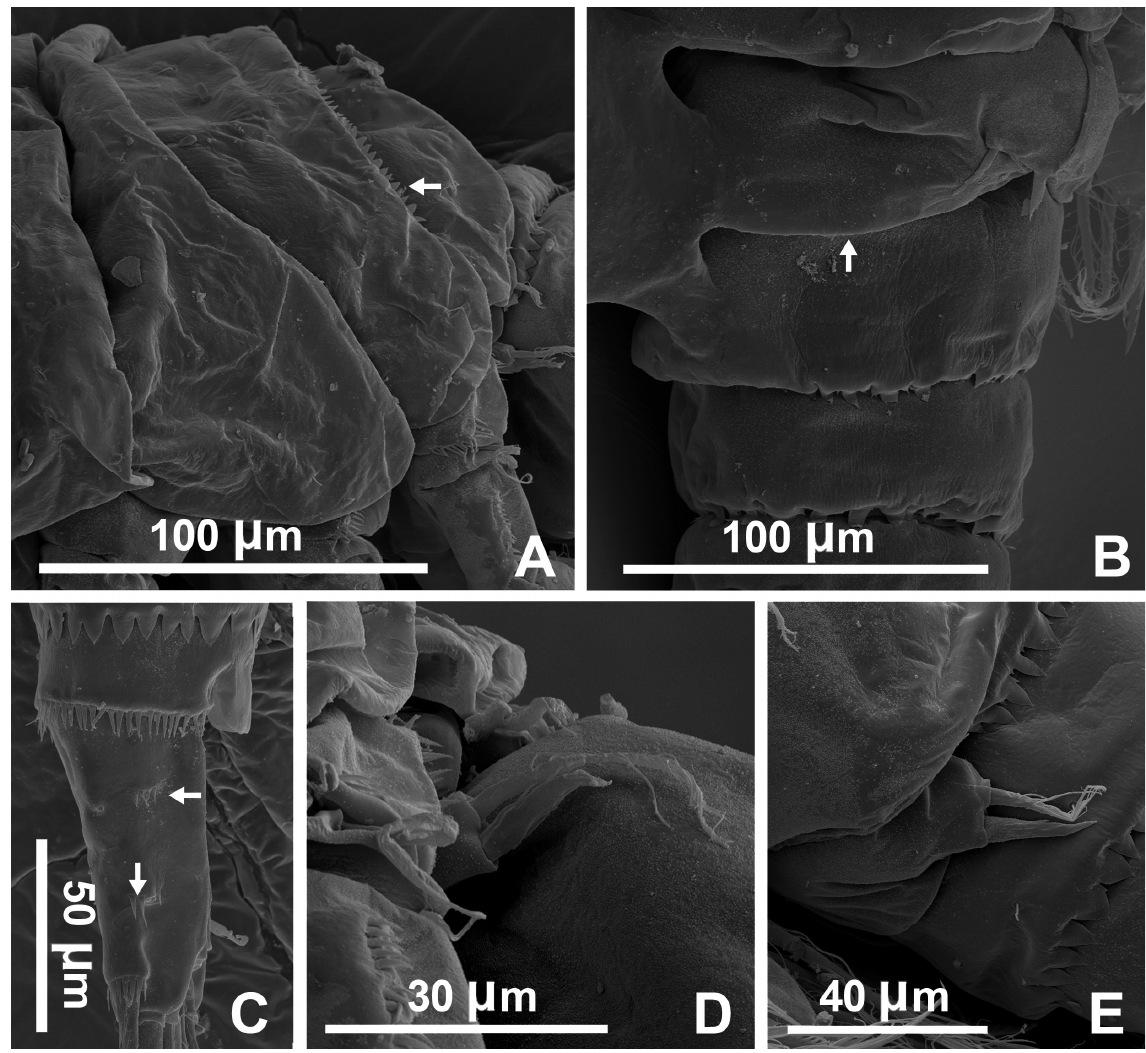
Fig. 11. Metacyclops brancelji sp. nov., SEM photographs of additional material (Rakhang Thong Cave, Satun Province, collection of the third author CB), ♂ (A, C−E) and ♀ (B). A . Second and third pedigerous somites, lateral view (arrow indicates distal margin of third pedigerous somites). B . Genital double-somite and second abdominal somite, dorsal view (arrow indicates posterior margin of the transverse suture). C . Caudal ramus, lateral view (arrows indicate spinules). D . P5, lateral view. E . Male P6, lateral